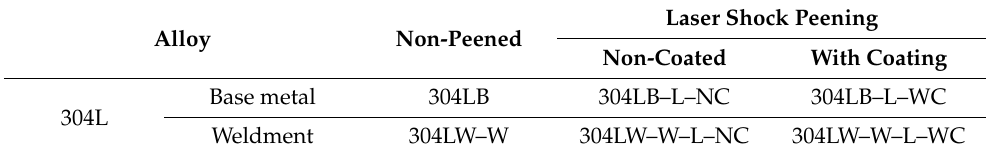
Table 3. Designation of the experimental specimen (Adapted with permission from [36]. 2022, MDPI). Alloy